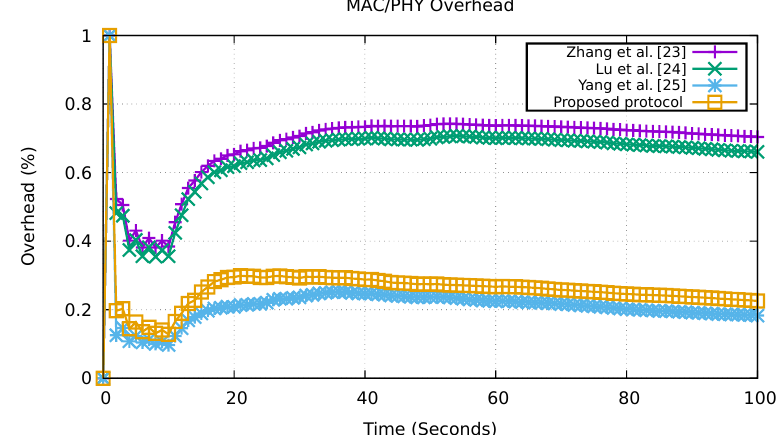
Figure 10. MAC/PHY overhead comparison.